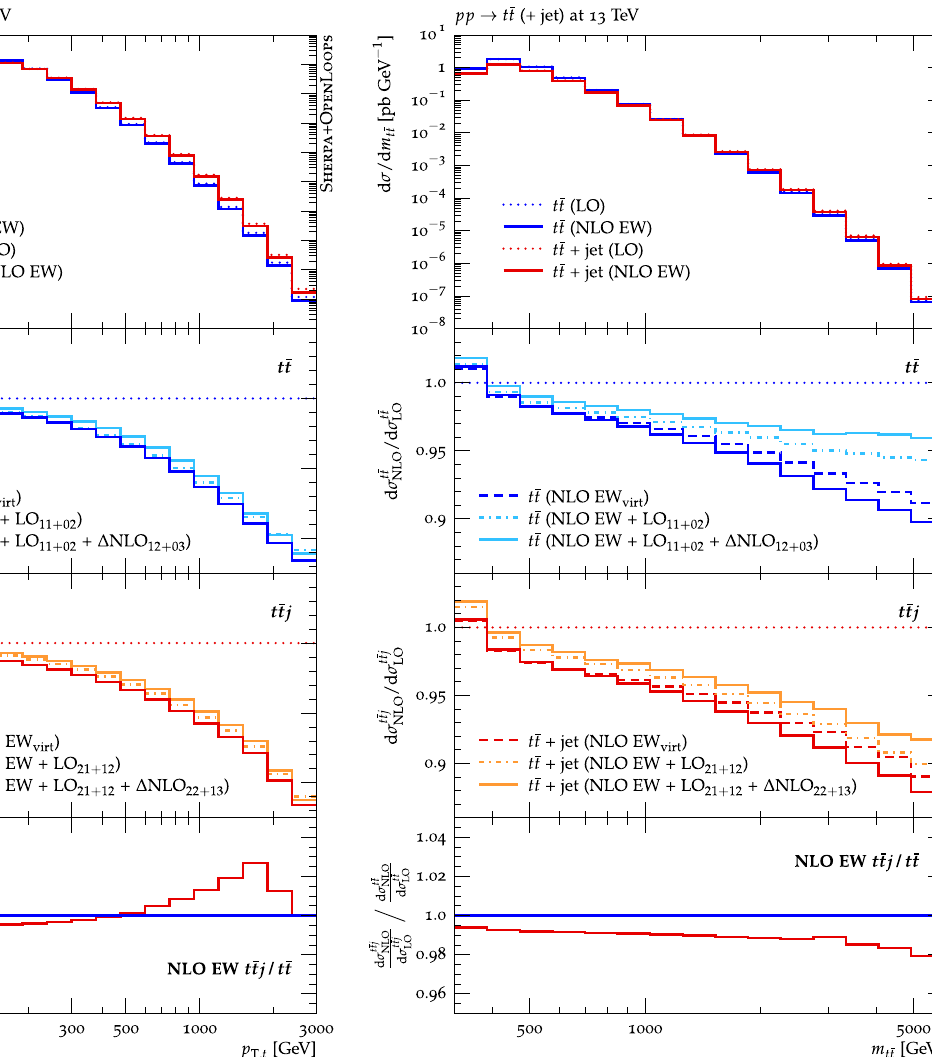
shown with lighter shades of the colour of the respective processes, dashed lines containing only the subleading Born contributions and solid lines containing all subleading Born and one-loop contributions. The lowest panel shows the ratio of the NLO EW corrections to the two processes. Corrections based on the NLO EW virt approximation are shown as the dashed line of the same colour as the exact NLO EW